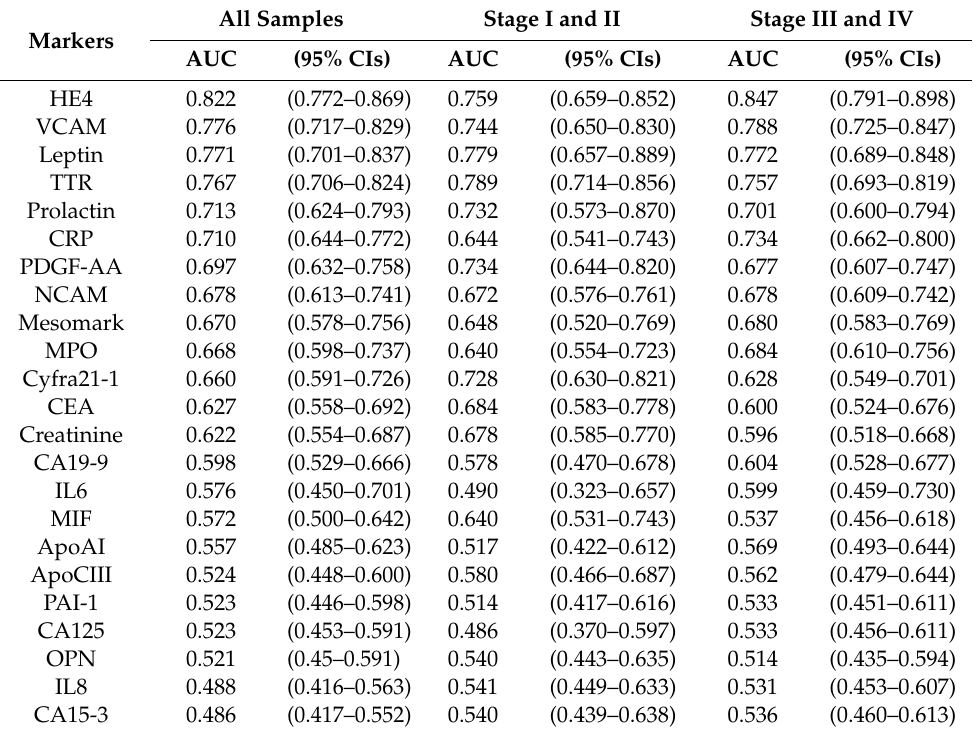
Table 2. The performance of each single biomarker in the urine samples to predict cancer over benign